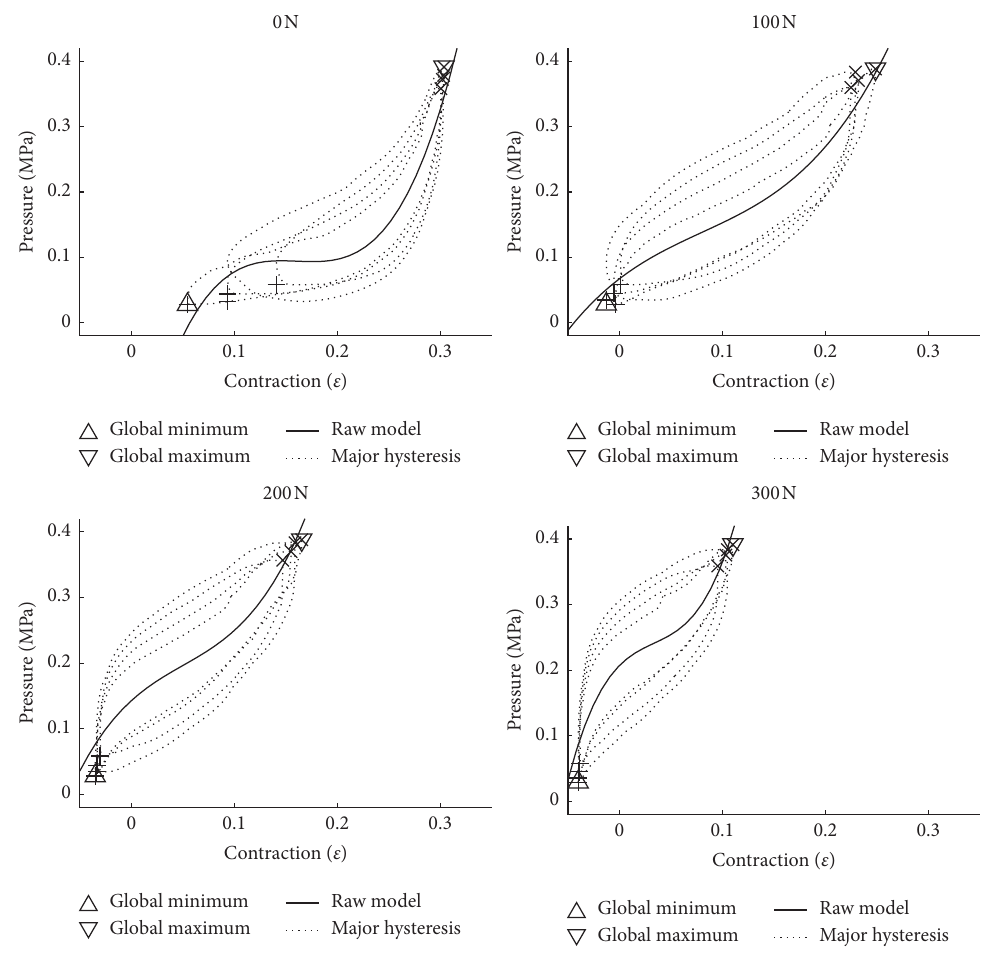
Figure 5: Identification of global maximum and global minimum of hysteresis data.